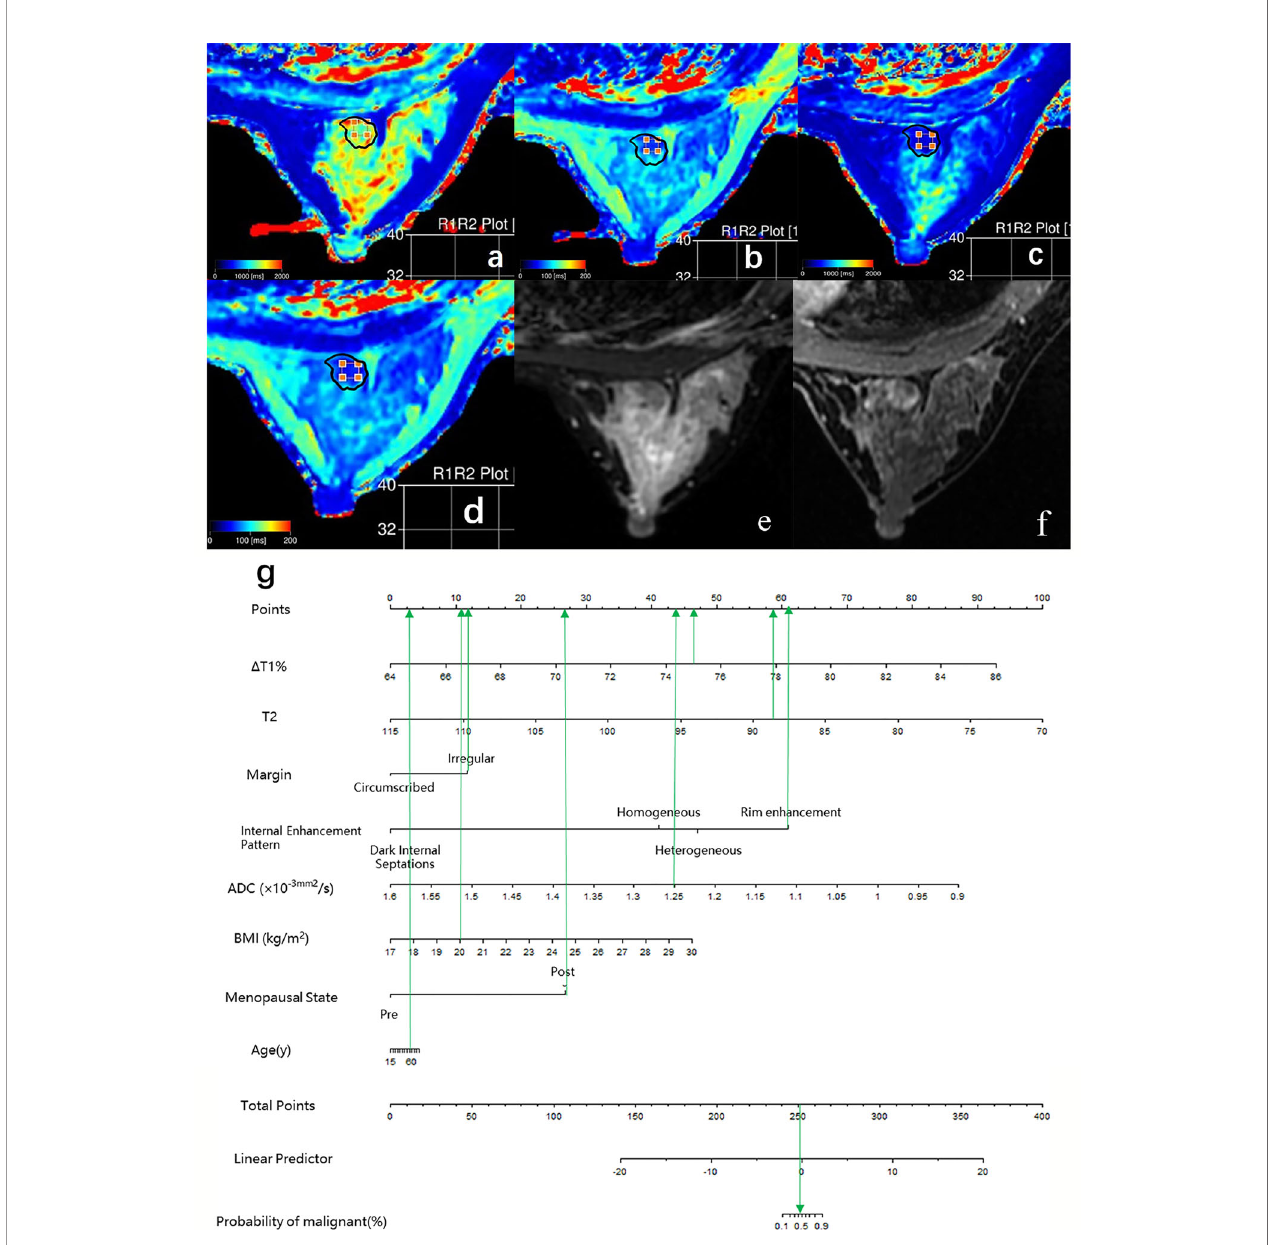
FIGURE 5 | Case 2: Application of prediction model 4 with nomogram in distinguishing breast cancer and benign diseases in BI-RADS 4 lesions. Female, 50 years, postmenopausal, BMI = 20, fi broadenoma, a – g. Image reconstruction with MAGiC, T1 map (A) , T2 map (B) , T1 enhancement map (C) , T2 enhancement map (D) , T2WI (E) , DCE (F) , Nomogram (G) . T1 = 1,275.43 ms, T1+ = 315.03 ms, D T1% = 75.30, T2 = 88.75 ms, T2+ = 83.90 ms, D T2% = 5.46%, ADC = 1.25 × 10 − 3 mm 2 /s, irregular margin and rim enhancement pattern. Total points = 253.18. Probability of malignant =